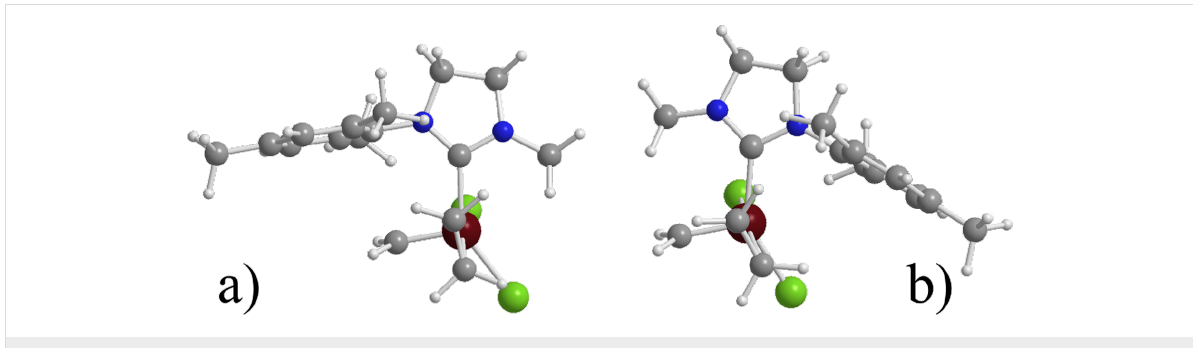
Figure 2: Coordinated species for species a) 13a and b) 13b .